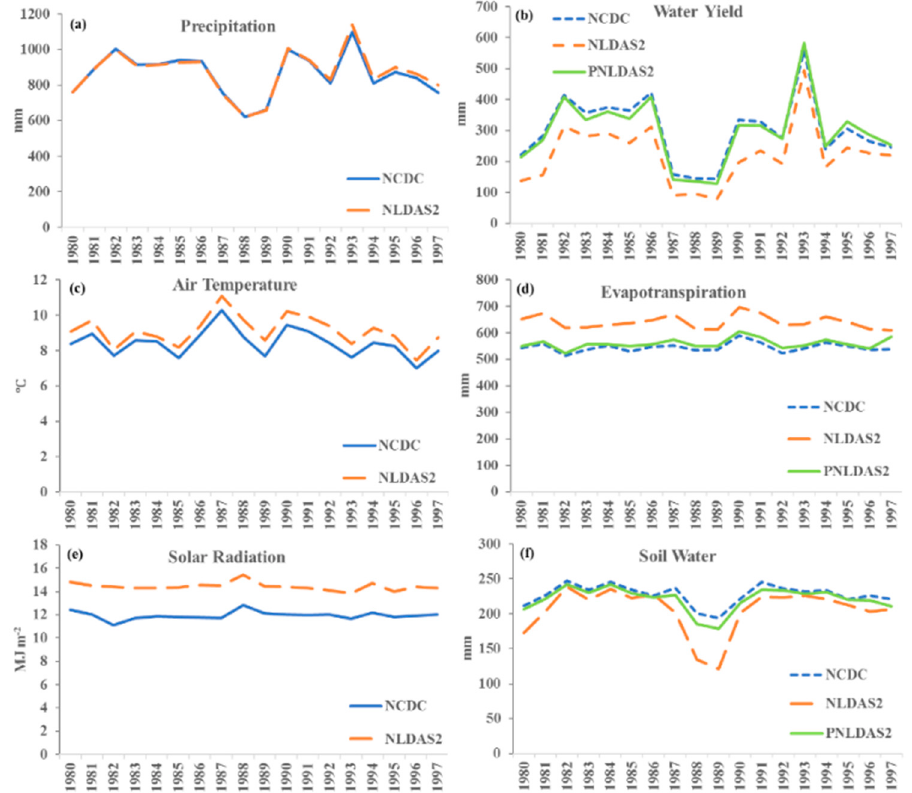
Figure 6. Annual average precipitation, daily air temperature, and daily solar radiation used in three scenarios compared with generated annual average water yield, evapotranspiration, and soil water over the UMRB using the uncalibrated SWAT model.